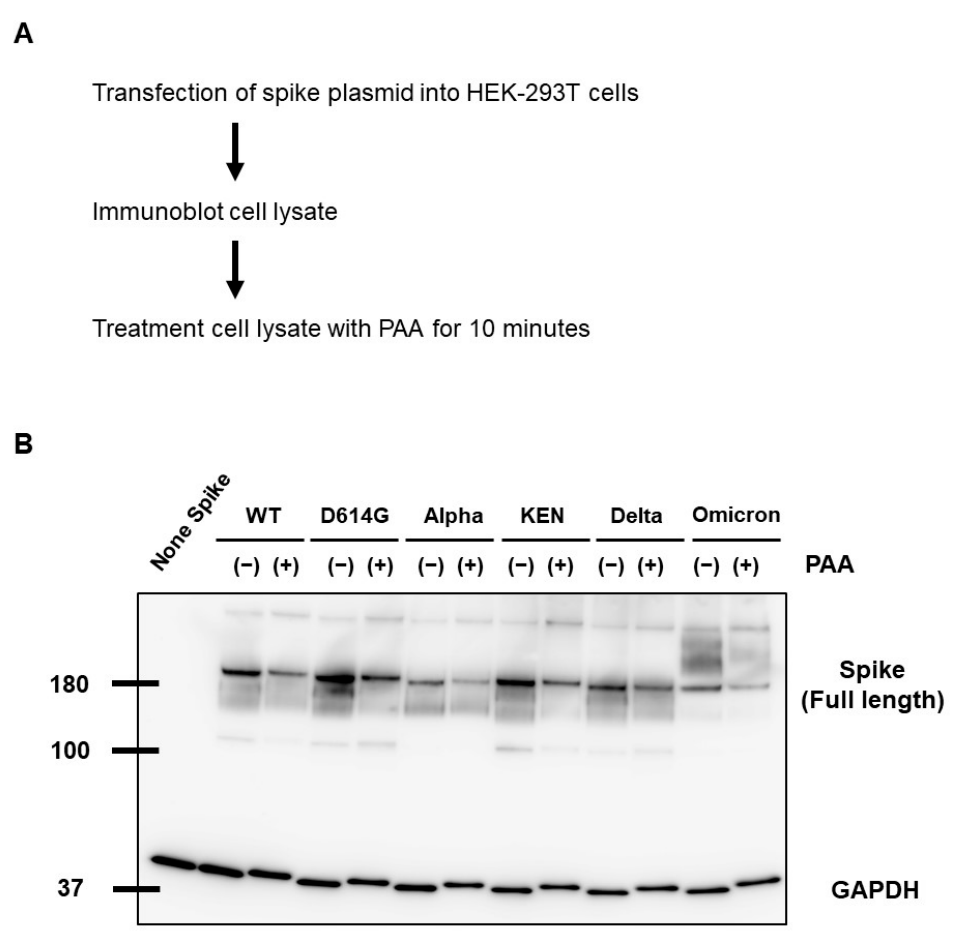
Figure 3. PAA led to SARS-CoV-2 spike protein destabilization. ( A ) WT and mutant spike proteins were expressed in HEK293T cells, and cell lysates were treated with PAA at a concentration of 0.01%. ( B ) Alteration of SARS-CoV-2 spike protein in PAA-treated cell lysates was detected by Western blot analysis. GAPDH is shown as a loading control. Experiments were repeated at least twice, and the representative data of the independent experiments are shown.